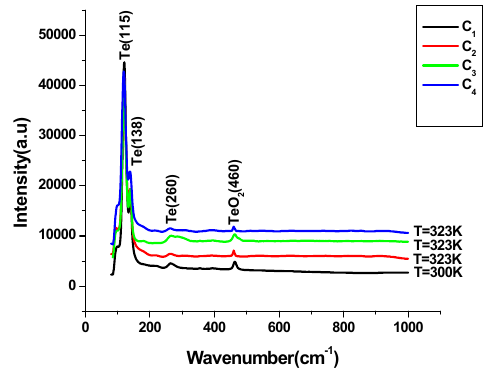
Fig. 4. Raman spectra for all samples with different thicknesses